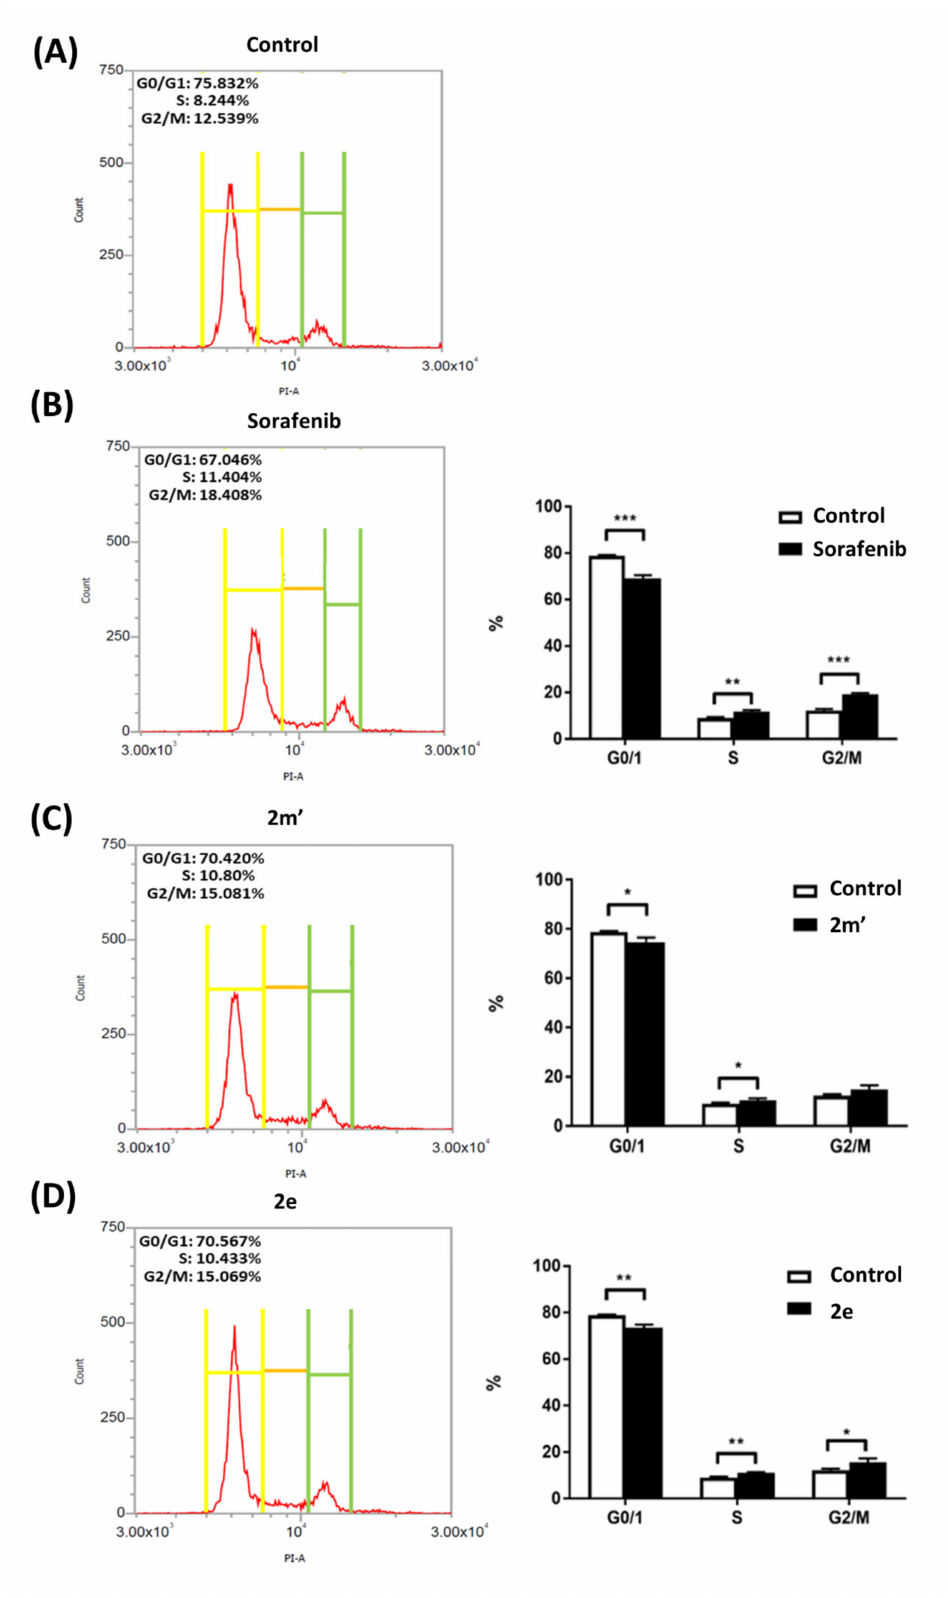
Figure 4. Cell-cycle distribution analysis of HepG2 cells treated with vehicle control ( A ), Sorafenib ( B ), compounds 2m’ ( C ), and 2e ( D ) as described in Materials and Methods. * p < 0.05, ** p < 0.01, *** p <